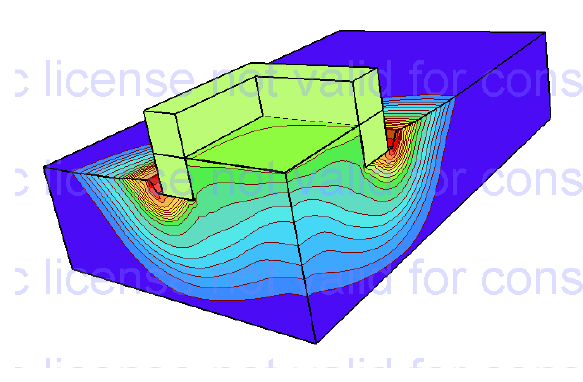
Figure 12: Failure mode of the bench and slab foundation, 3D calculations